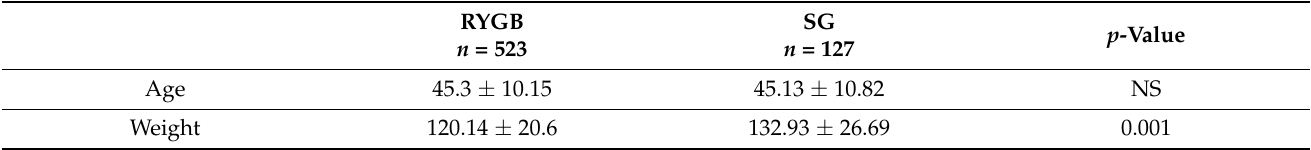
Table 1. Baseline distribution of age, gender, comorbidities, and weight between